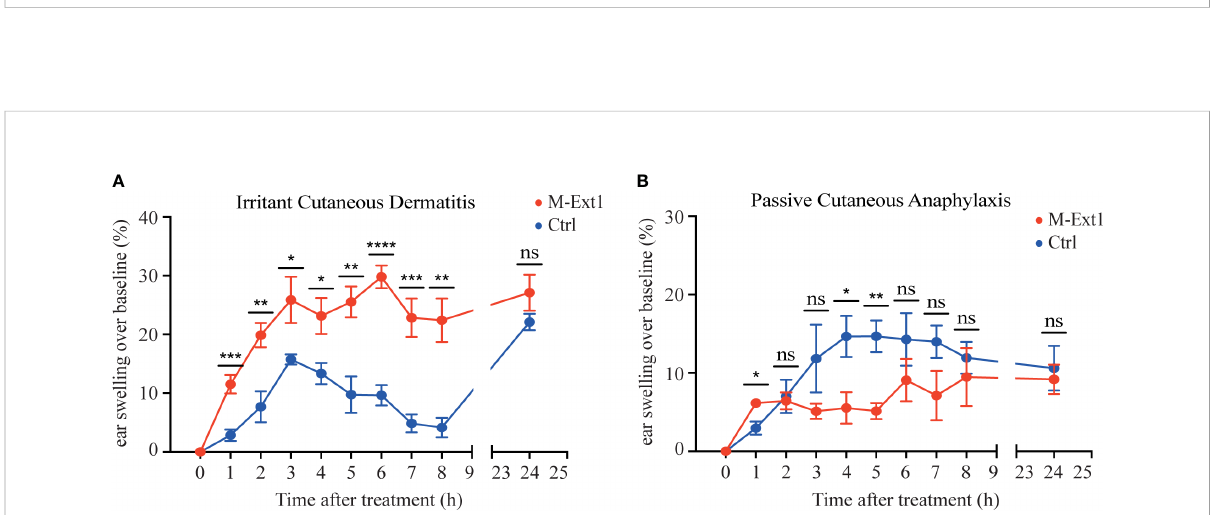
FIGURE 6 Heparin de fi ciency augments skin in fl ammation upon irritant challenge but not in PCA model in 14-weeks old mice. (A) The change of ear thickness over baseline between M-Ext1 and control mice at the indicated time points after 0.5% DNFB application. (B) The change of ear thickness over baseline between M-Ext1 and control mice after i.v. injection of chicken ovalbumin (Ova) following prior sensitization with mouse anti-Ova IgE of M-Ext1 and controls mice. Results are represented as mean ± SEM from 3-6 mice of each genotype. Each symbol in the graphs is an individual mouse. Statistical signi fi cance was determined by unpaired Student ’ s t-test. In (A, B) , the comparison between M-Ext1 and control mice was done for each time point. Values of p<0.05 were considered statistically signi fi cant, *p < 0.05, **p < 0.01, ***p < 0.001, ****p < 0.0001, ns, not signi fi